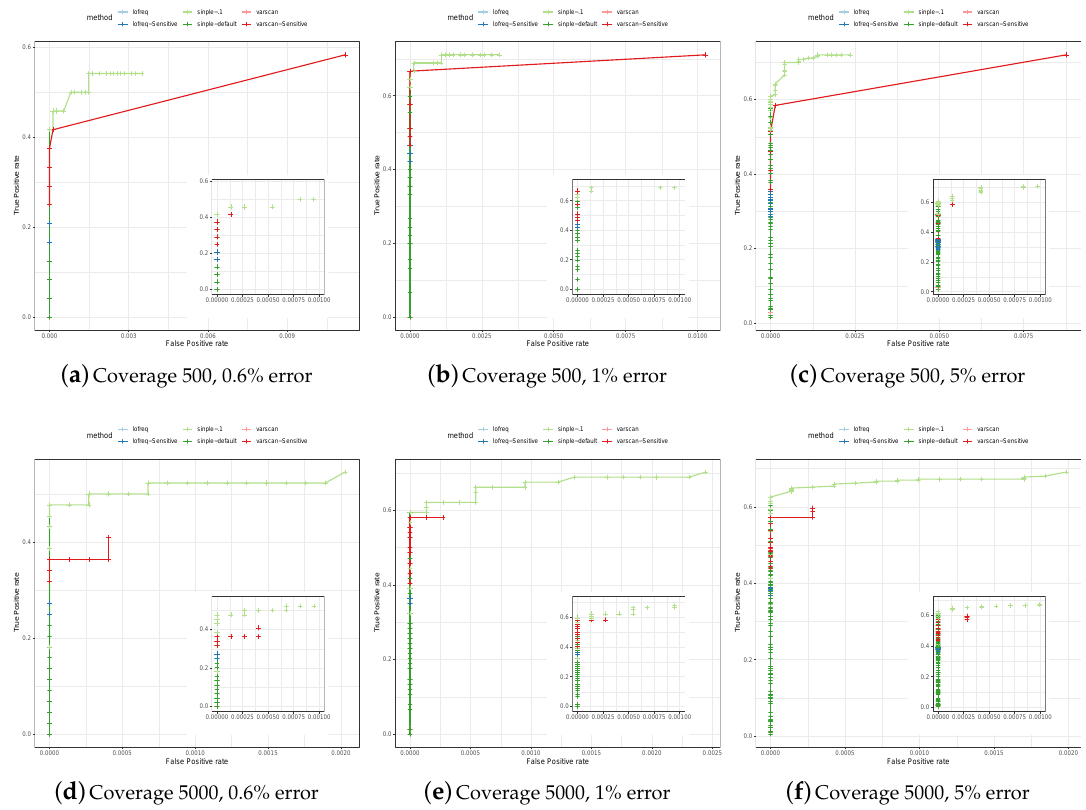
Figure 2. Comparison of variants discovered on simulated poliovirus data by SiNPle (Simplified Inference of Novel Polymorphisms from Large coveragE), LoFreq and VarScan2. We simulated coverages of 500 and 5000, and for each coverage value three different levels of error: 0.6%, 1%, and